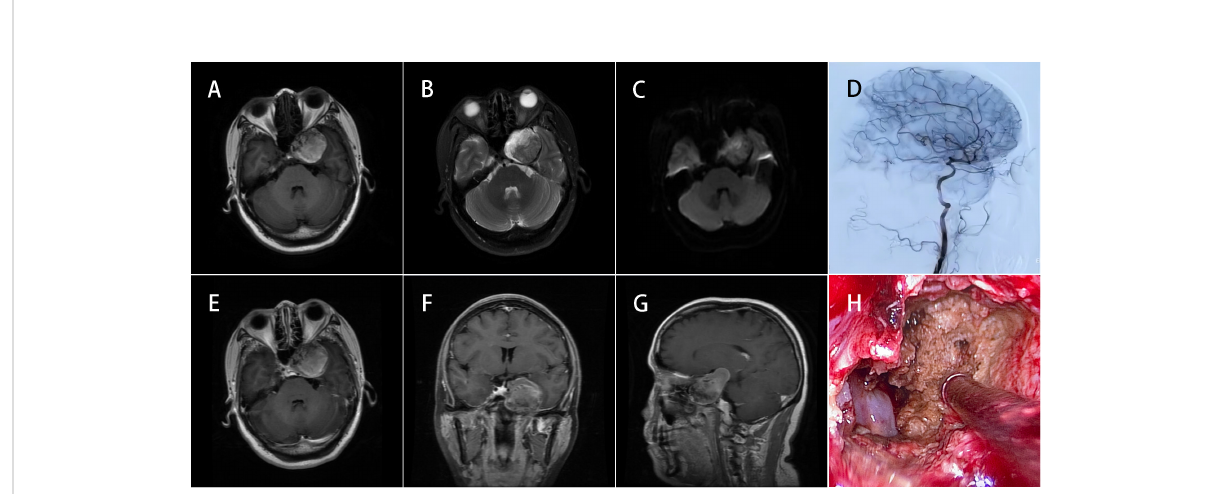
FIGURE 1 MRI of the brain with and without contrast. (A) The left CS lesion was approximately 34 mm × 30 mm in size with a clear boundary but showed mixed signals that were mostly hyperintense on T1-weighted imaging. (B) Hypointense signals can be seen on T2-weighted imaging. (C) Heterogeneous signals appeared on DWI. (E – G) No obvious gadolinium enhancement was noted. (D) DSA con fi rmed that the embolization effect on the aneurysm was satisfactory and the shape of other intracranial vessels was smooth. (H) Endoscopic fi ndings revealed that the lesion contents comprised tan mushy